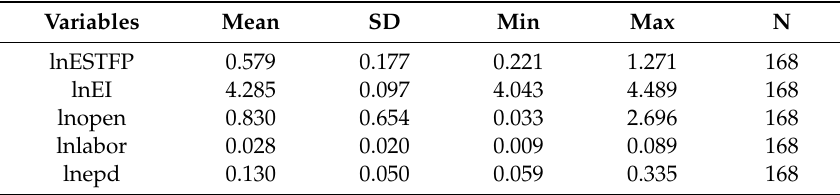
Table 3. Descriptive Statistics of Variables.